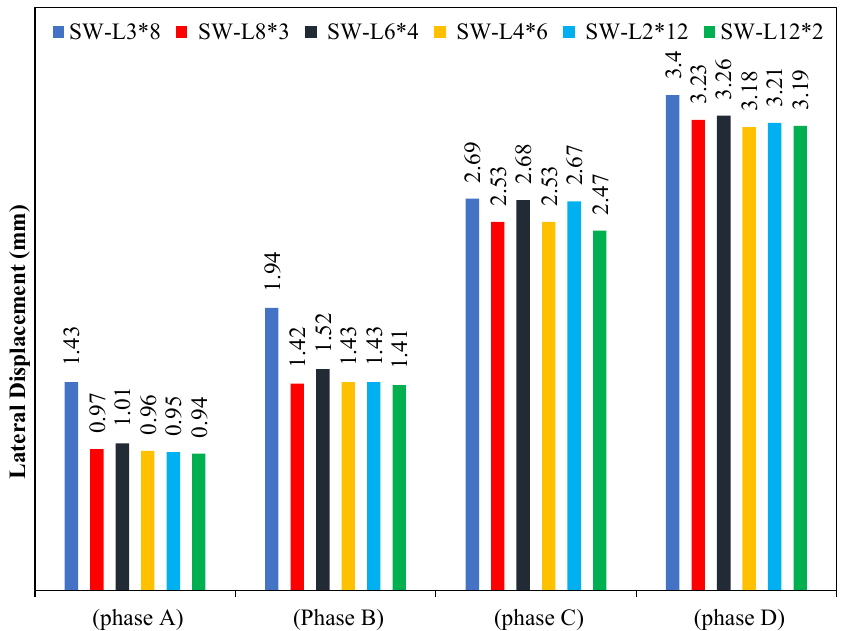
Figure 23. Lateral displacement of group 4.